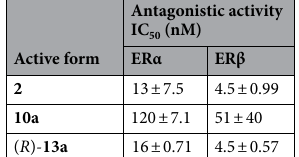
Table 4. ER-antagonistic activities of the active